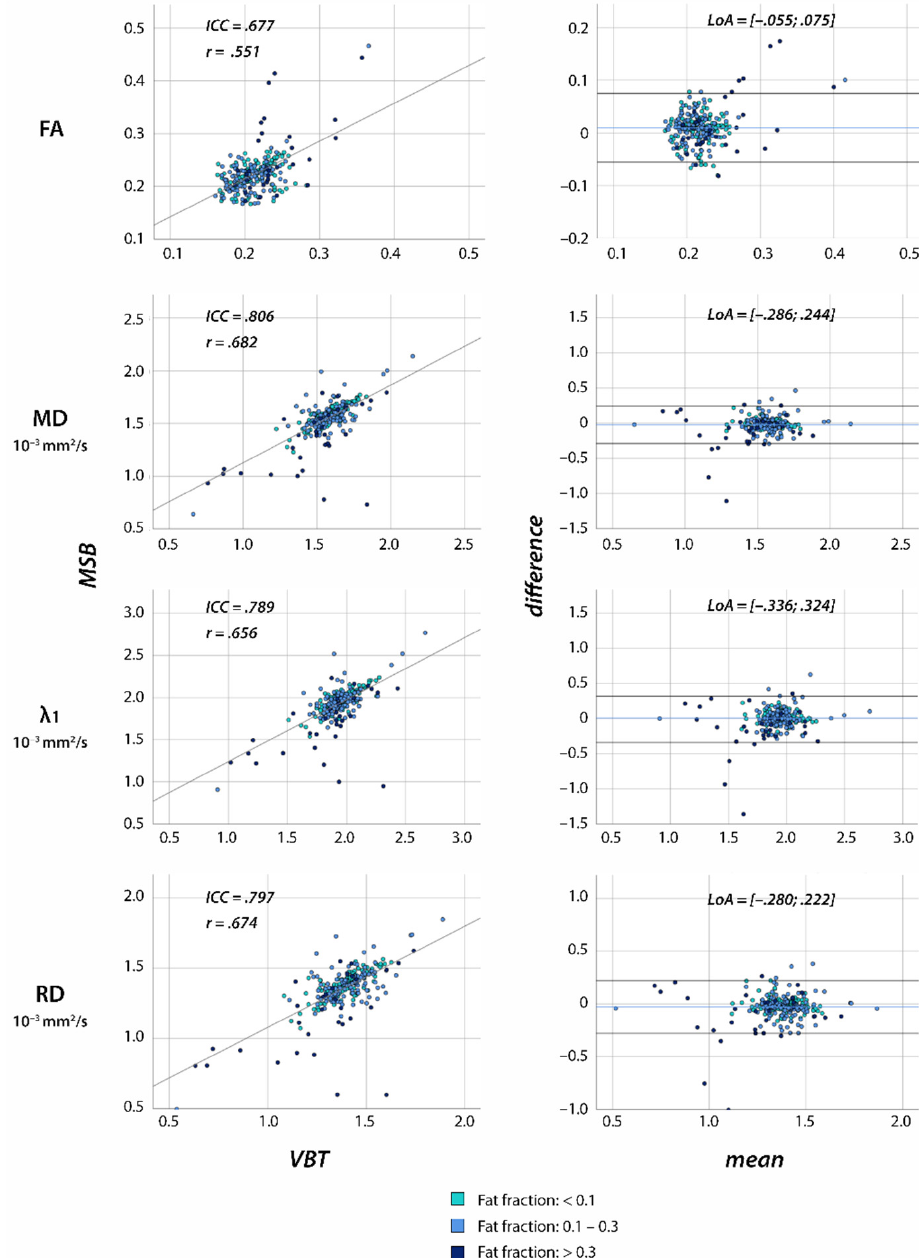
Figure 6. Scatter plots of correlation and Bland-Altman plots between VBT and MSB for one rater in individuals with neuromuscular diseases. Scatter plots include Pearson (r) and intraclass correlation coefficient (ICC). In Bland-Altman plots, the x-value shows the mean of two raters and the y-value the difference between the raters. The colored lines show the mean of the paired difference; the black lines show LoAs from − 1.96 s to 1.96 s.